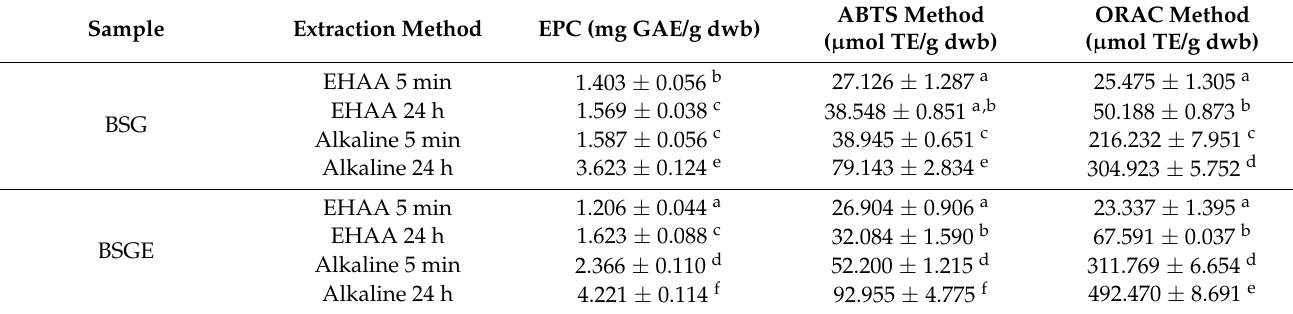
Table 6. Phenolic content and antioxidant capacity of BSG and BSGE’s extracts.